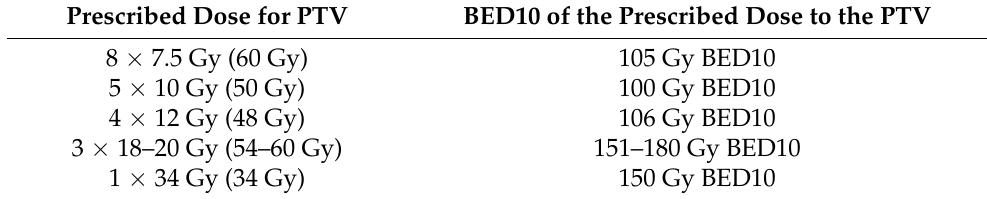
Table 4. CARO clinical practice guidelines for lung